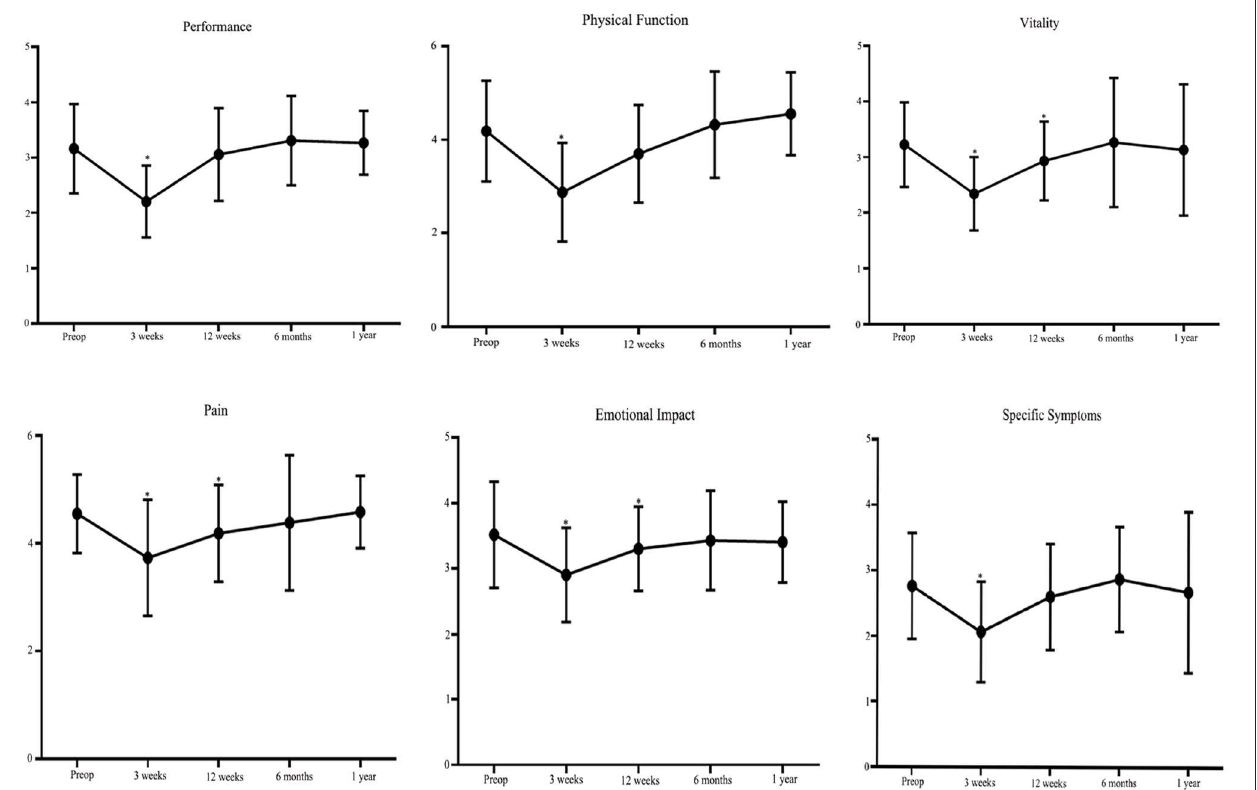
FIGURE 1 | Plots illustrating preoperative and postoperative scores for each of the six domains assessed using the Anterior Skull Base Questionnaire (ASBQ) after endoscopic nasopharyngectomy in patients with recurrent nasopharyngeal carcinoma. A higher score indicates better quality of life. * p < 0.05 (paired t test).